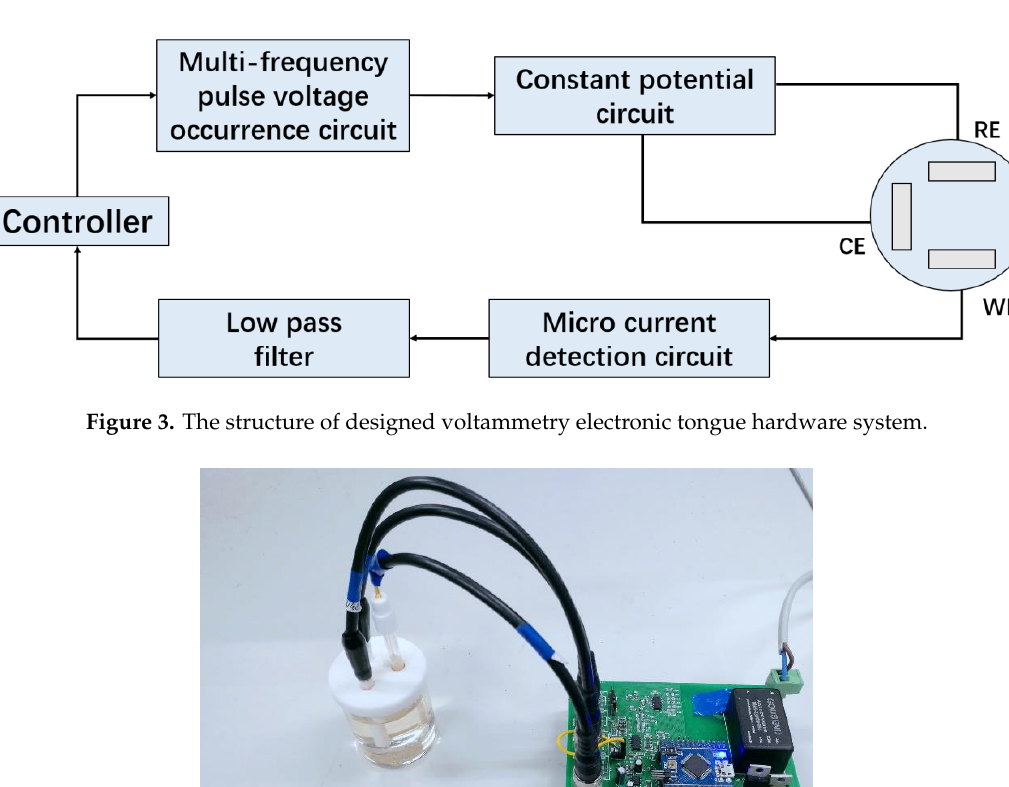
Figure 3. The structure of designed voltammetry electronic tongue hardware system. Table 1. The details of the electrode sensor array.